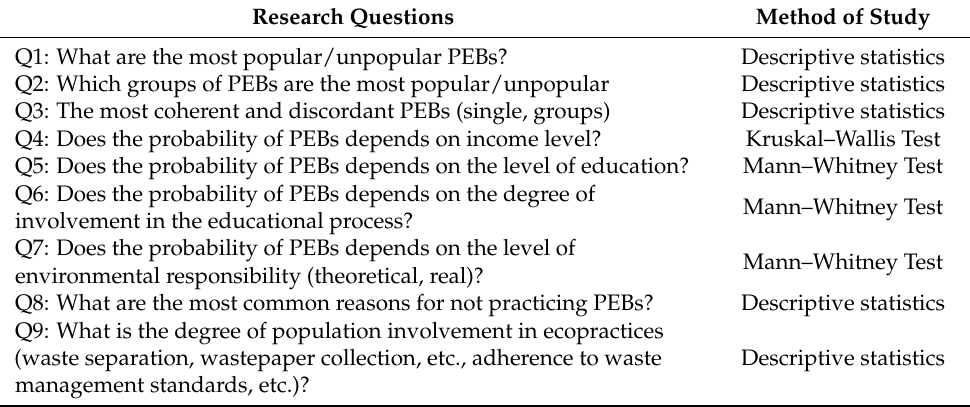
Table 2. Research questions and